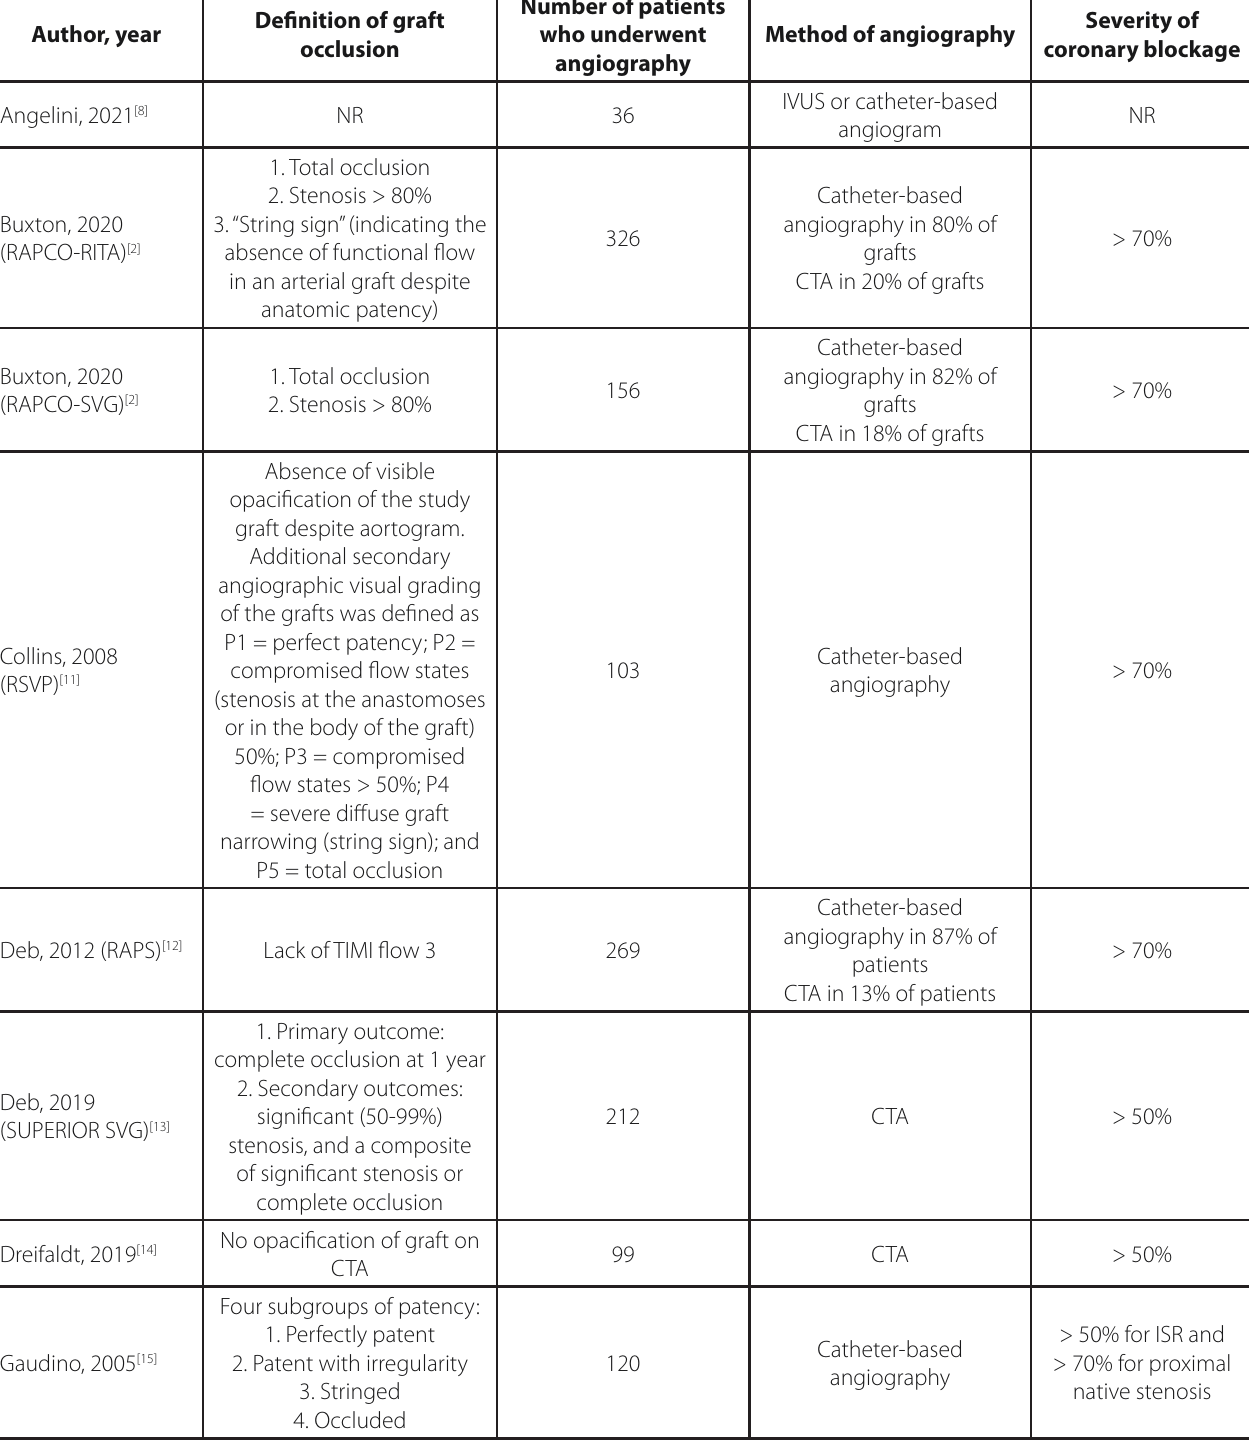
Table S5. Angiography-related variables by